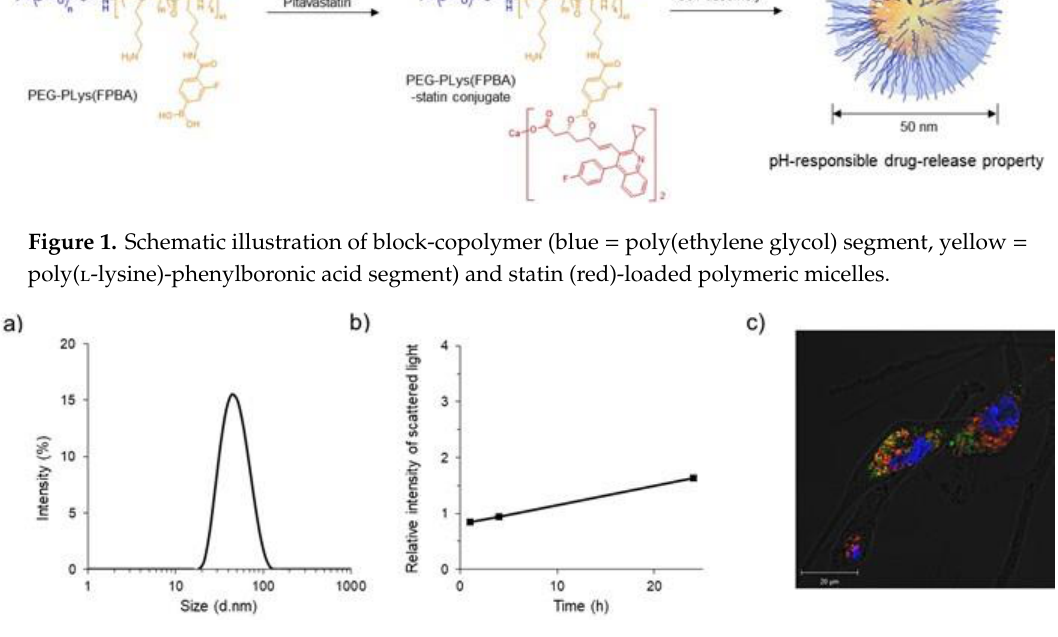
Figure 2. Characteristics of pitavastatin-loaded polymeric micelle (PS / m) and in vitro confocal laser scanning microscopy (CLSM) images. ( a ) Size distribution of PS / m in 10 mM phosphate bu ff er (pH 7.4), as measured by dynamic light scattering (DLS). Concentration: 0.5 mg-pitavastatin / mL, temperature: 25 ◦ C. ( b ) Stability of PS / m in 10 mM phosphate bu ff er (pH 7.4) as measured by DLS. Concentration: 0.5 mg-polymer / mL, temperature: 37 ◦ C. ( c ) In vitro CLSM of Alexa 647-labeled PS / m uptake in smooth muscle cells (SMCs). The cells were incubated with the micelle solution for 24 h at 37 ◦ C. The picture shows merged images, which include the nuclei (blue), PS / m (red), and lysosome (green). Their colocalization is shown in yellow. Scale bars: 20 µ m. Table 1. The 50% inhibitory concentrations with PS / m and free pitavastatin vs. smooth muscle cell. Free